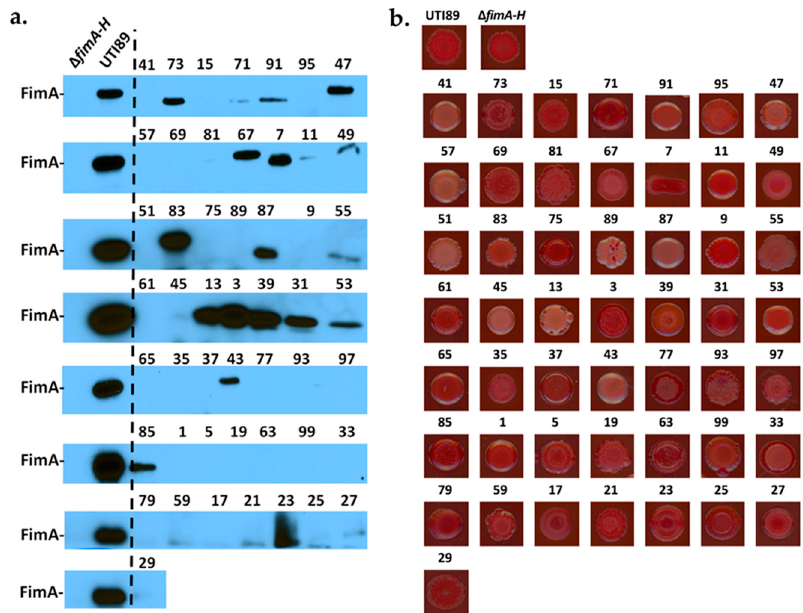
Figure 3. Urinary isolates form variable levels of known biofilm matrix components. ( a ) Immunoblot depicts the abundance of FimA pilin subunit in the 50 VUTI strains. Cultures were grown statically overnight under atmospheric conditions. The antibody used to probe for FimA production was raised against the FimA antigen of cystitis strain UTI89 [45], which is used here as a positive control. The size of UTI89 FimA is roughly 18.5 kDa. An isogenic strain deleted for the entire fim operon ( ∆ fimA-H ) is used as a negative control. This immunoblot indicates that 27/50 isolates express a FimA isoform or a pilin subunit recognized by the anti-FimA antibody used. The immunoblot shown is representative of a minimum of two biological replicates; ( b ) VUTIs were spotted on yeast extract/casamino acids (YESCA)–Congo Red agar and grown at room temperature for seven days. Congo Red uptake serves as a proxy to cellulose and curli presence in the extracellular matrix. Representative images of two independent experiments are shown here.